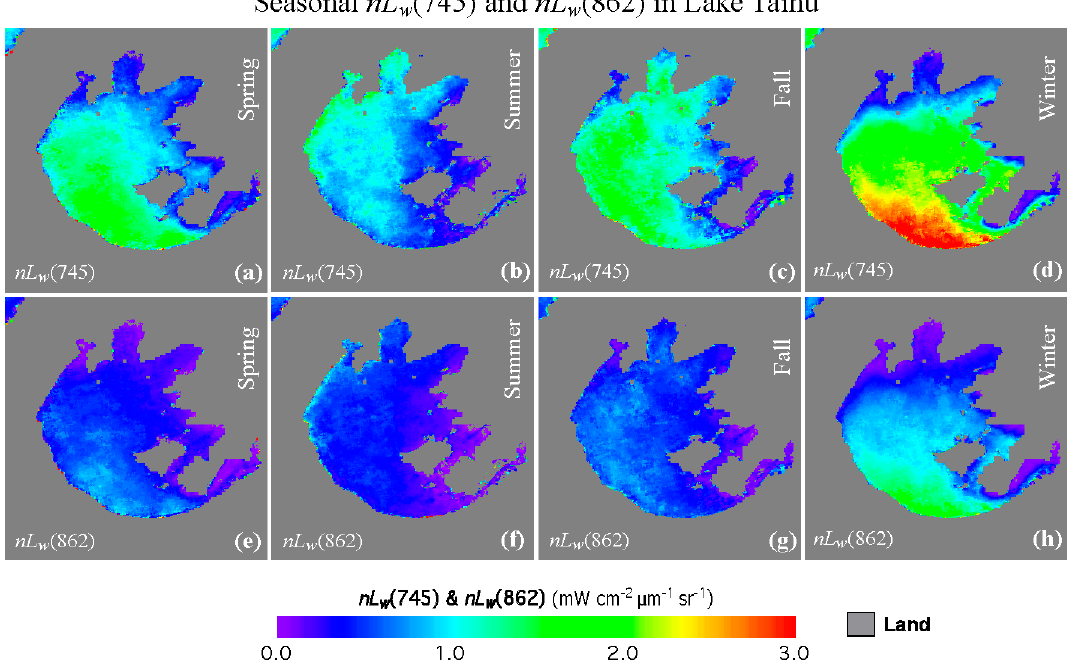
Figure 5. Seasonal climatology nL w (745) images ( a – d ) and nL w (862) images ( e – h ) for spring, summer, autumn, and winter from VIIRS 2012–2016 measurements, respectively.